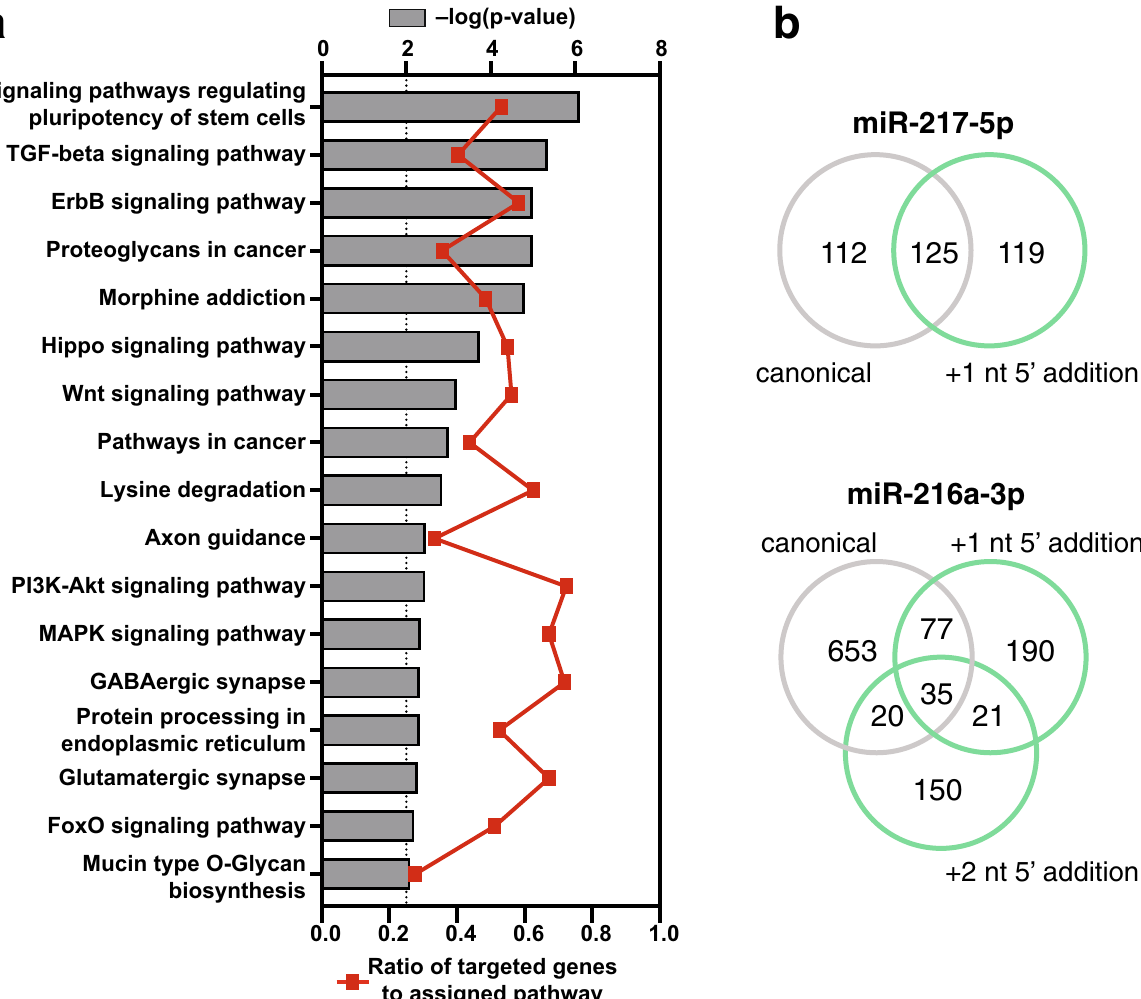
Figure 6. Target analysis of miRNAs and isomiRs affected by metformin. ( a ) KEGG pathways significantly enriched in predicted target genes of the 11 miRNAs showing a significant U-shaped/inverted U-shaped trend among Young/SEN/SEN + M samples. Pathways are ranked according to the significance of enrichment (grey bars, upper y-axis). Ratios referring to the proportion of targeted genes related to the total number of genes in each pathway are displayed (red line graph, bottom y-axis). ( b ) Results of the TargetScan custom analysis on the canonical and 5 ′ isomiR seed sequences of miR-217-5p and